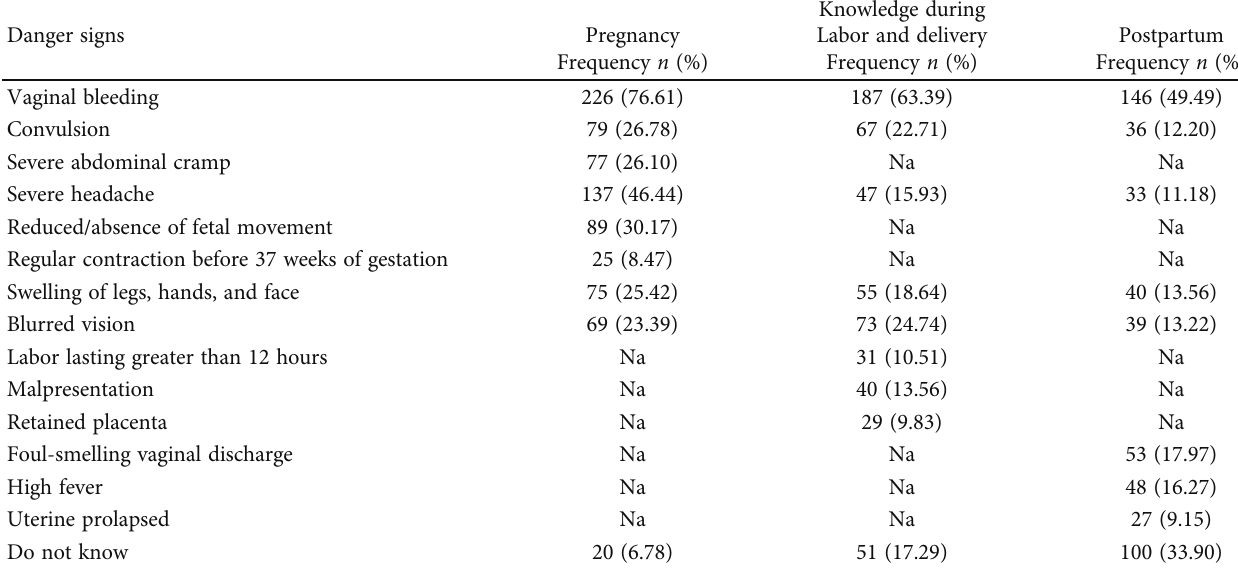
Table 5: Knowledge on obstetric danger signs among pregnant women in Debre Tabor town, Northwest Ethiopia, 2021. Danger